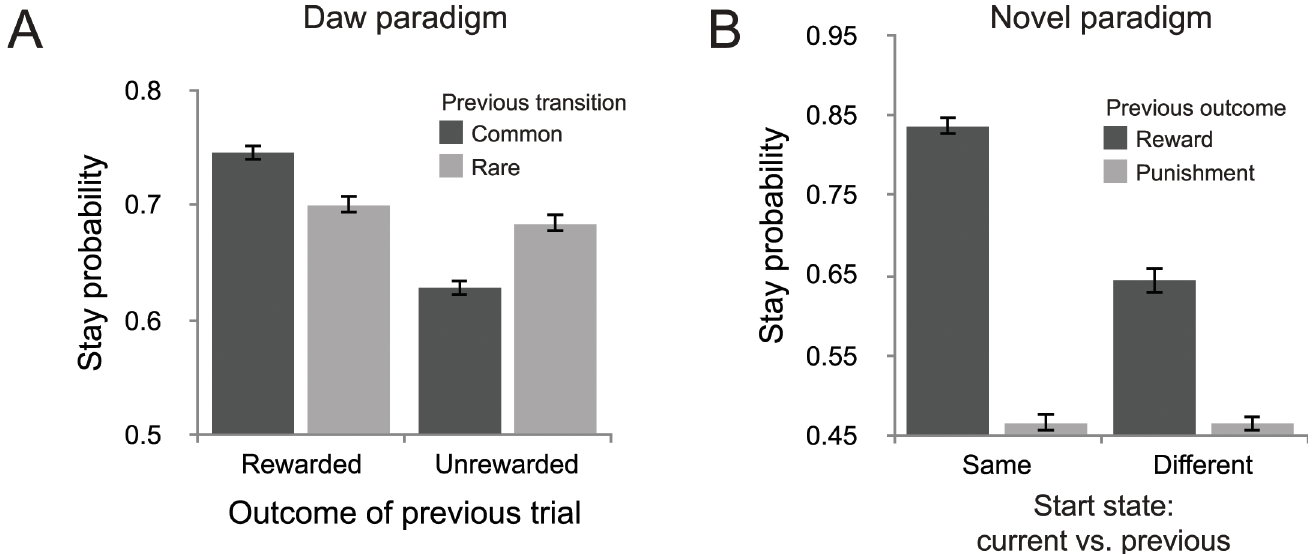
Fig 16. Behavioral performance on the two-step tasks. (A) Behavioral performance on the Daw task showed both a main effect of previous outcome and an interaction between previous outcome and transition type, suggesting that behavior showed both model-based and model-free strategies. (B) Behavioral performance on the novel paradigm showed a significant difference in stay behavior between same and different start states conditions after a reward, suggesting that behavior was not fully model-based. Error bars indicate within-subject